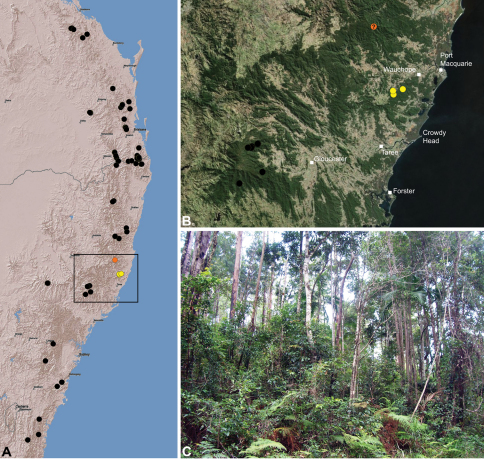
Austrarchaea binfordae sp. n., distribution and habitat: A, topographic map showing the known distribution of Archaeidae in south-eastern Queensland and eastern New South Wales, with collection localities for A. binfordae highlighted in yellow (orange localities denote genotyped juvenile specimens of tentative identification); B, satellite image showing detail of inset (A); C, lowland subtropical rainforest at the type locality – McLeods Creek Road, Kerewong State Forest, New South Wales (April 2010). Image (C) by M. Rix.